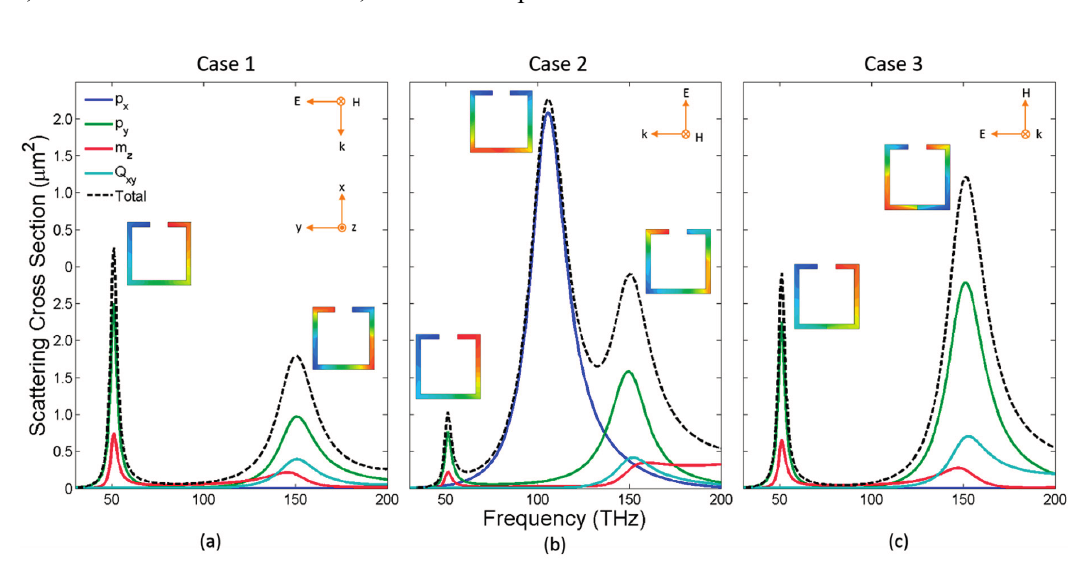
Figure 2. Multipolar decomposition of the scattering cross-section, for a 1-SRR between 30 THz and 200 THz, into the lowest order multipoles; ( a ) Case 1: electric field in-plane and along the gap, magnetic field out-of-plane; two resonances are observed at f 1 = 51 THz and f 3 = 151 THz ( b ) Case 2: electric field in-plane and normal to the gap, magnetic field out-of-plane; three resonances are observed, those observed in case 1 plus another one at ( c ) Case 3: electric and f 2 = 106 THz due to the excitation of the electric dipole, (cid:1868) (cid:3051) magnetic fields in-plane, along the gap and normal to it, respectively; two resonances are observed, just as in Case 1. The resonances excited in Case 1 and 3 yield both an electric , and a magnetic dipole, (cid:1865) , response. Resonance 3 also shows an in-plane dipole, (cid:1868) (cid:3052) (cid:3053) , response in all cases. Insets show the real part of (cid:1831) at the corresponding quadrupole, (cid:1843) (cid:3051)(cid:3052) (cid:3053) resonance frequencies using a rainbow colormap (min in blue, zero in green, and max in